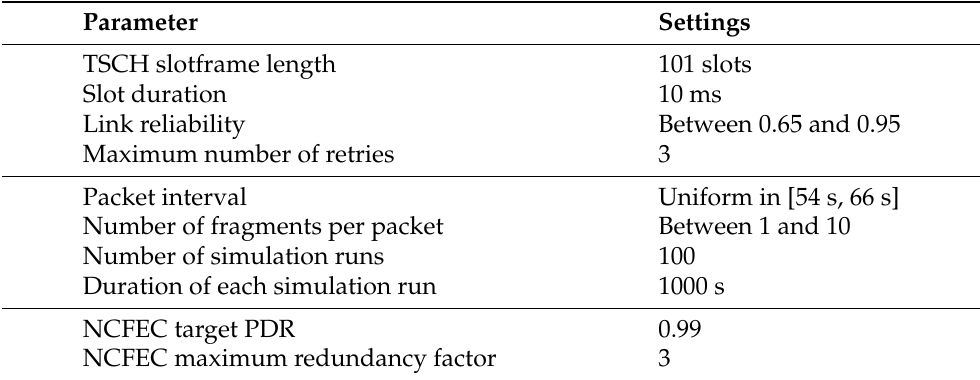
Table 1. Simulation